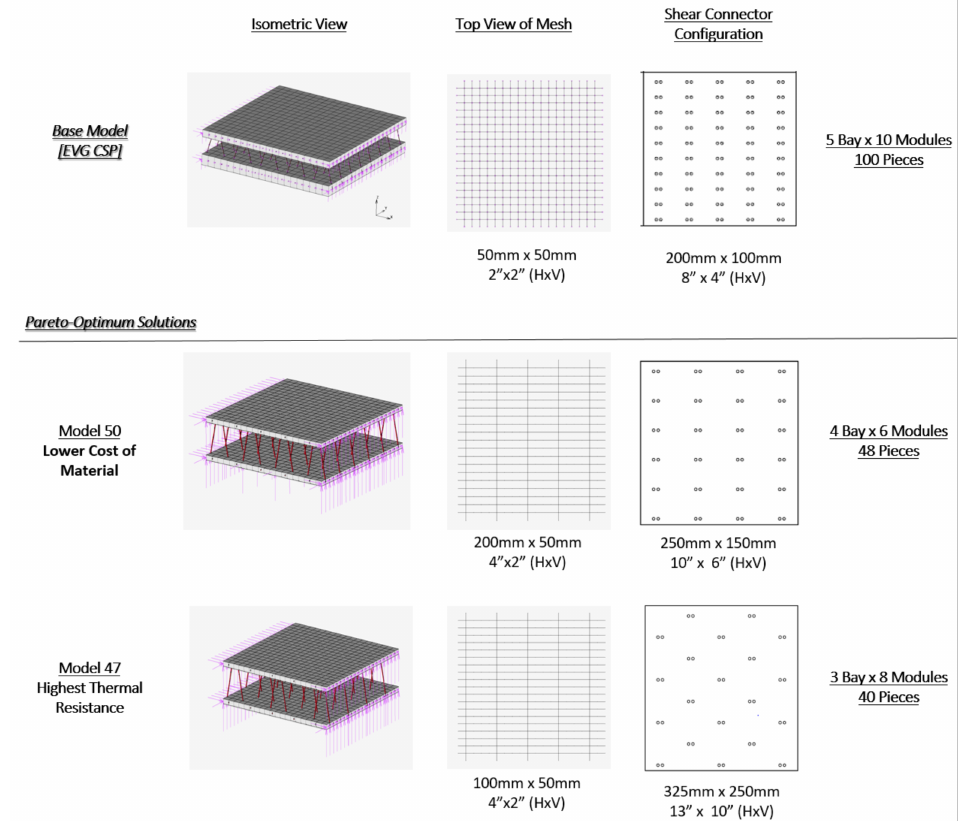
Figure 17. Graphical representation of CSP Topology Optimization using GA.